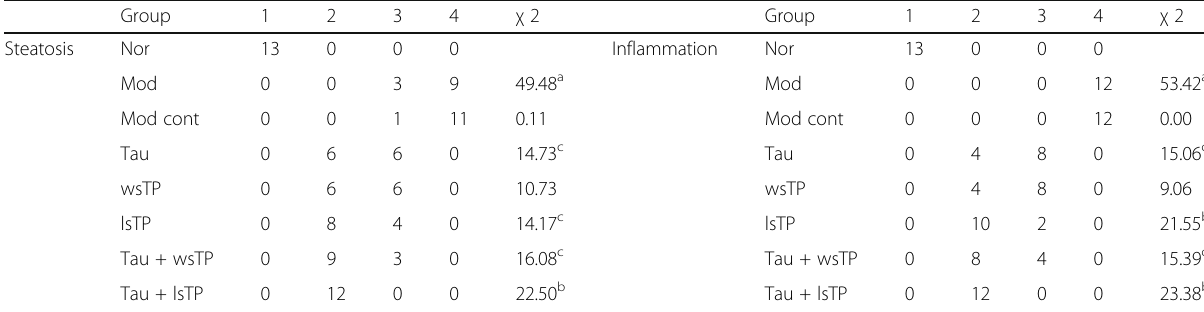
Nor normal group, Mod model group, Mod cont model control group, Tau taurine treatment group, wsTP water soluble tea polyphenols treatment group, lsTP lipid soluble tea polyphenols treatment group, Tau + wsTP taurine and water soluble tea polyphenols treatment group, Tau + lsTP taurine and lipid soluble tea polyphenols treatment group. Kruskal – Wallis H-test and Nemenyi test were used in the statistical analysis. a P < 0.01 compared with Normal group; b P < 0.01 compared with Model control group; c P < 0.05 compared with Model control